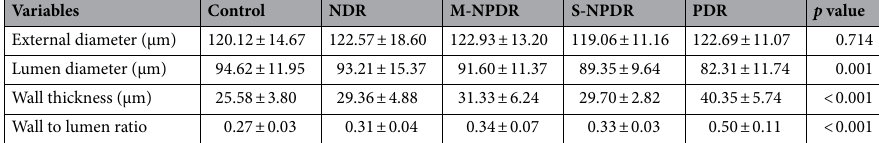
Table 2. Retinal artery variables measured by AO